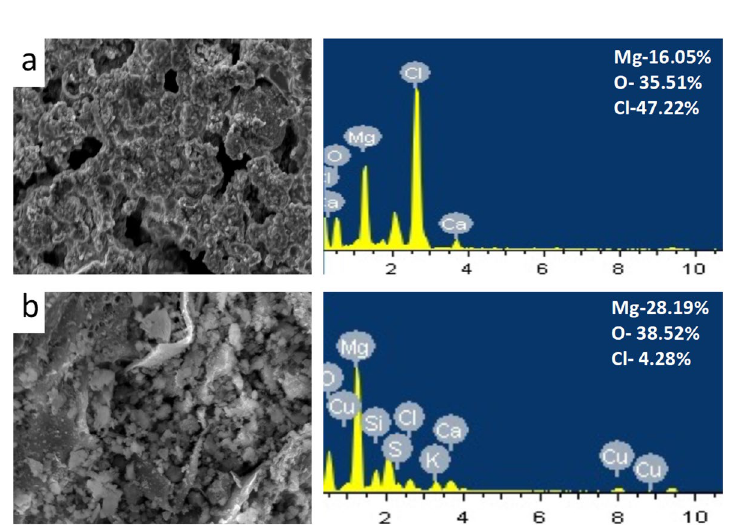
Figure 3. Scanning electron microscopy-energy dispersive X-ray spectroscopy analysis of ( a ) chemical- modified and ( b ) electro-modified Mg-laden microalgal